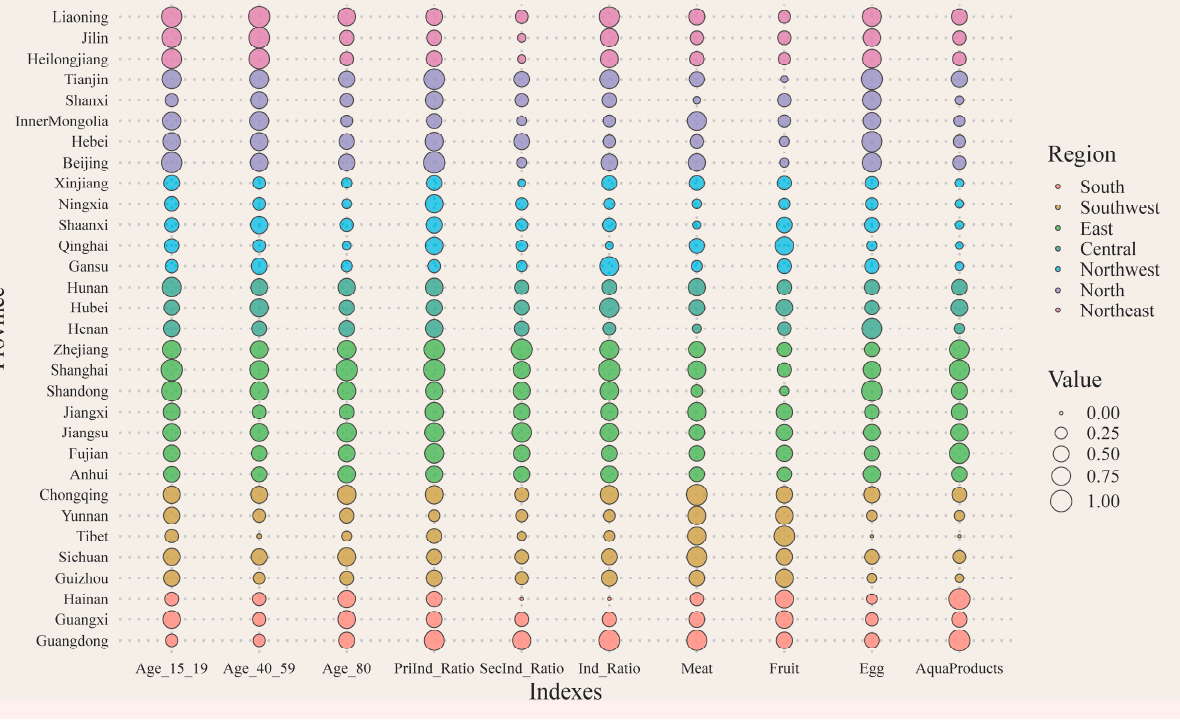
Figure 7. Distribution map of standardized values of main sensitivity indicators for each province.